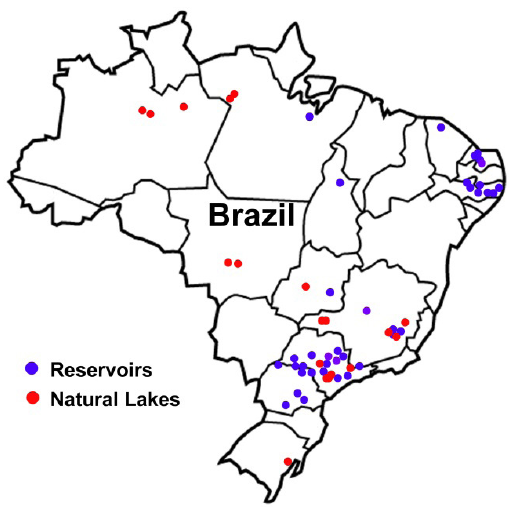
Figure 1. Distribution of the natural (red circles, N = 32) and artificial (blue circles, N = 51) lakes used in this study.